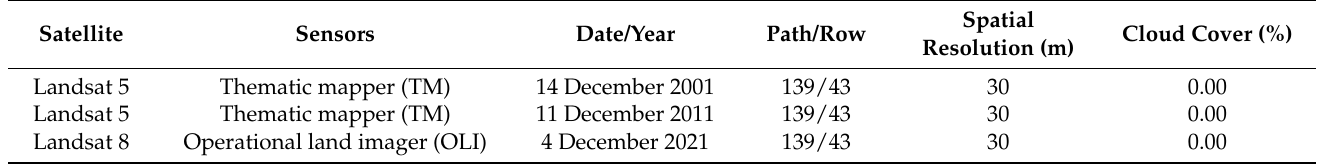
Table 1. Details of multitemporal satellite images and their characteristics.